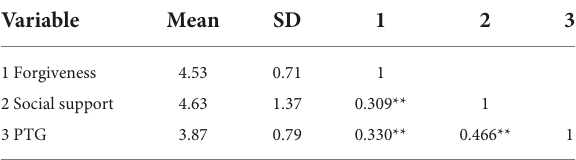
TABLE 2 The Pearson correlation among forgiveness, social support, and post-traumatic growth